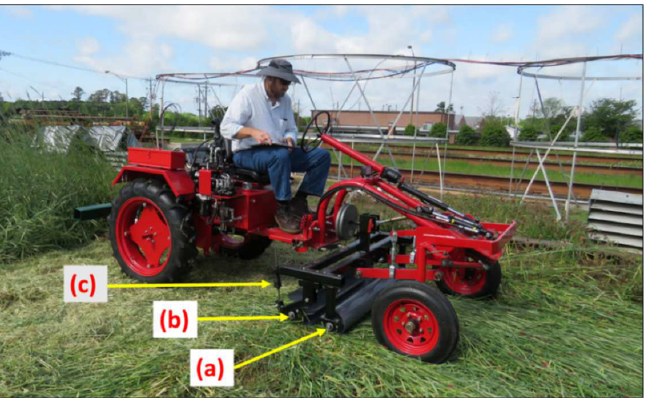
Figure 1. Oggun tractor with mid-mounted patented 2-stage roller/crimper [13]. ( a ) smooth drum for flatting cover crop and serves as the base for roller’s stability; ( b ) secondary drum with crimping bars to injure cover crop in equal intervals; ( c ) compression spring to maintain down force for increased crimping efficiency.